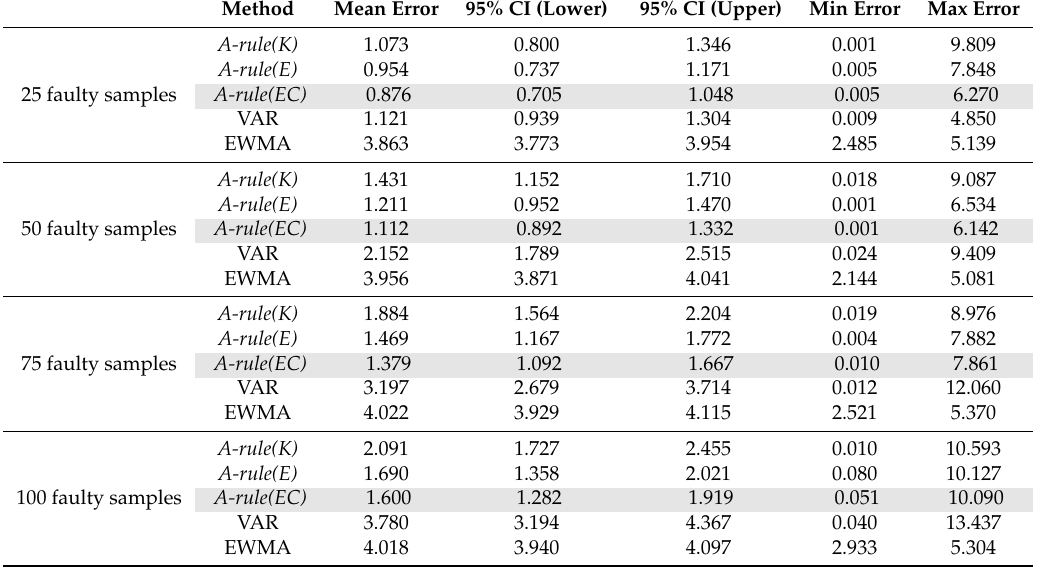
Table 2. Error in cleaning temperature data with a different number of faulty samples for 100 data sets.